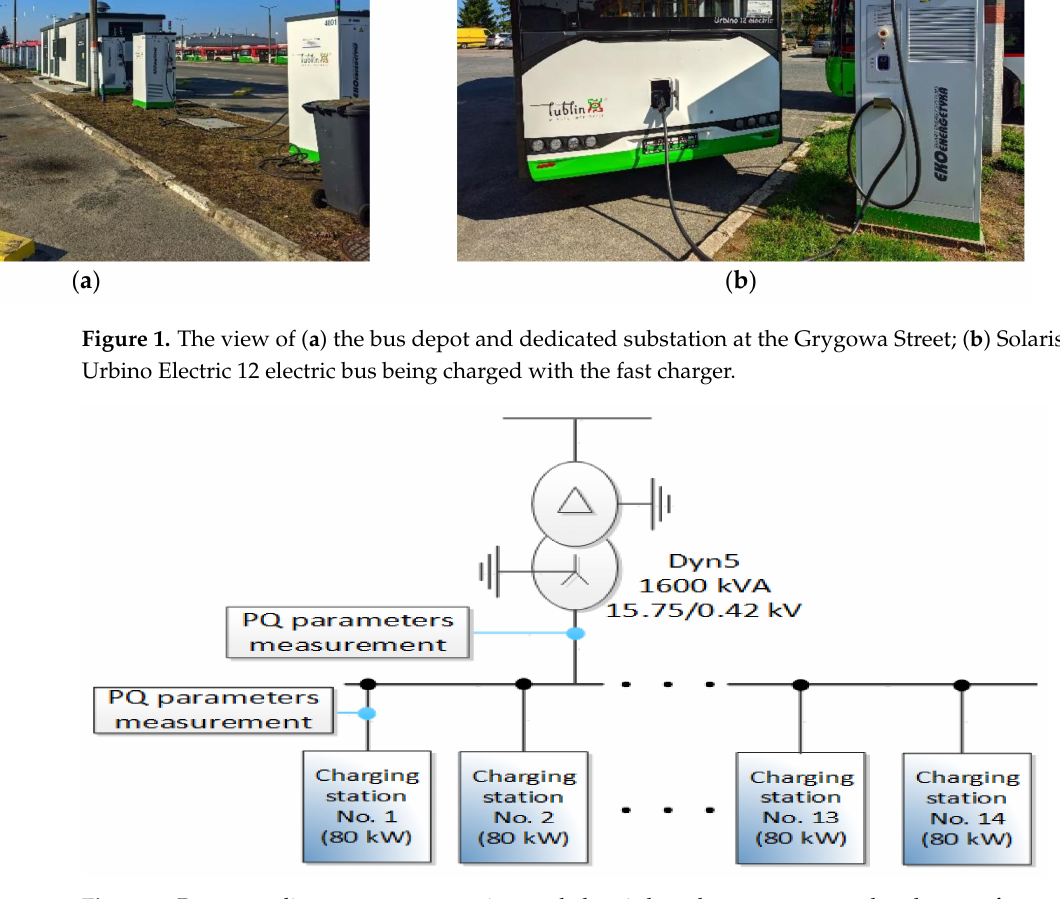
Figure 2. Power quality measurement points and electric bus chargers connected at the